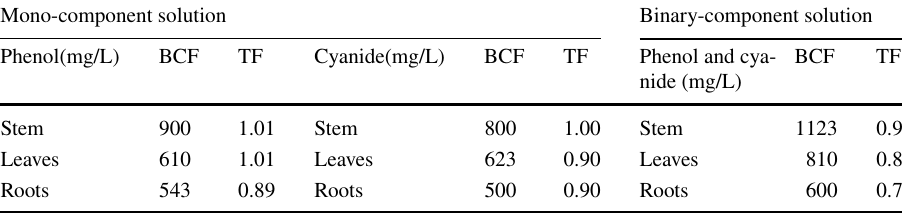
Table 4 BCF and TF in plants after 13 days exposure to phenol and cyanide in mono and binary component